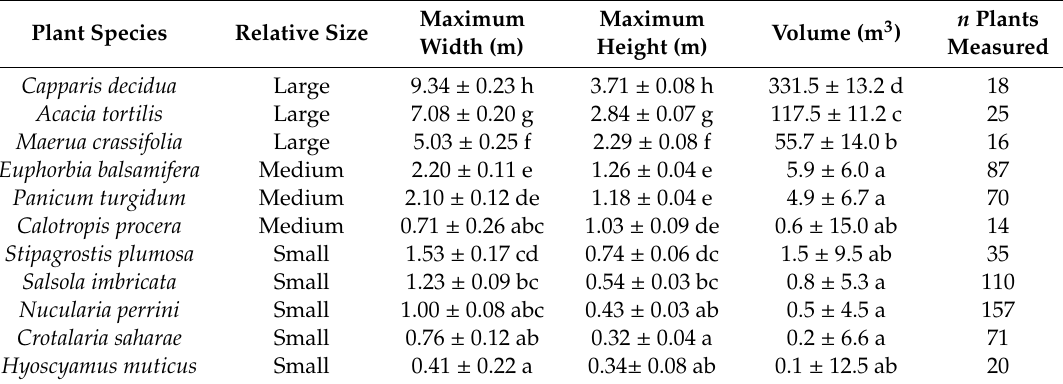
Table 2. Mean ( ± SE) plant sizes of 11 dominant plant species in the four survey sites.